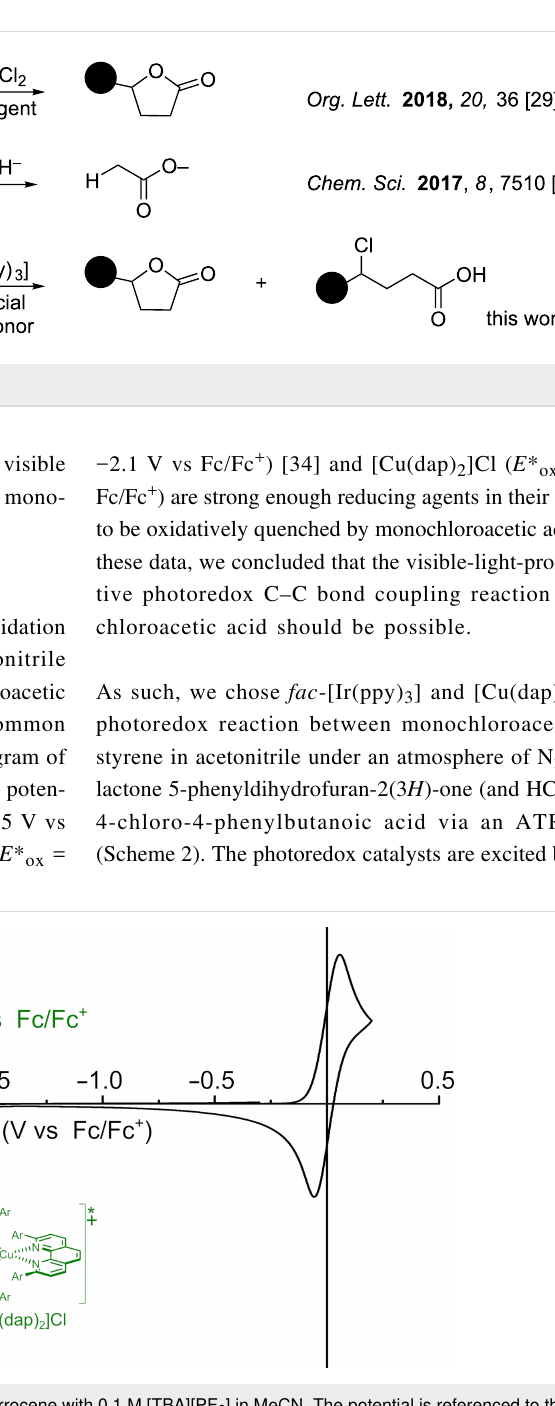
Figure 2: Cyclic voltammogram of monochloroacetic acid and ferrocene with 0.1 M [TBA][PF 6 ] in MeCN. The potential is referenced to the Fc/Fc + redox couple (0 V). The excited state reduction potentials of two different reducing photoredox catalysts (in red and green) are shown in the figure.